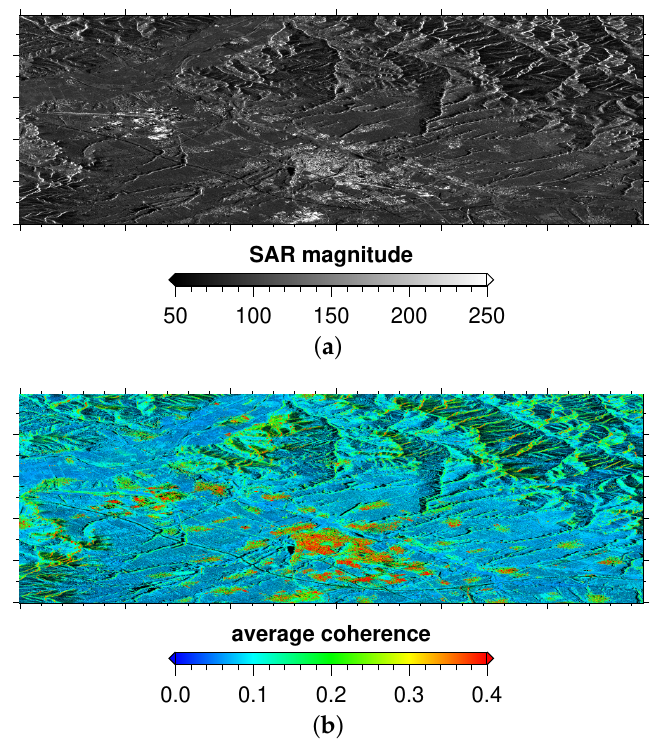
Figure 3. ( a ) The average SAR amplitude; ( b ) the average coherence map overlaid on ( a